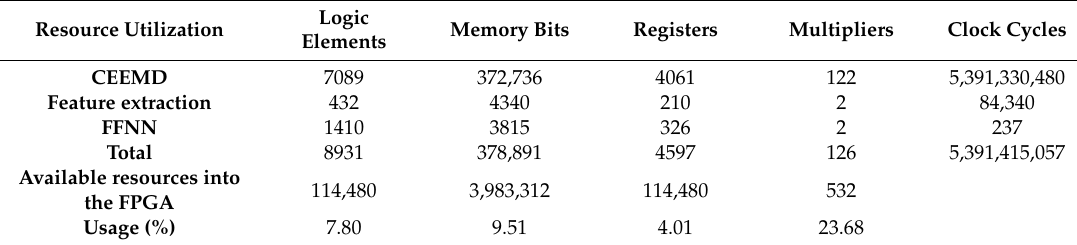
Table 2. Resource usage of the FPGA platform.